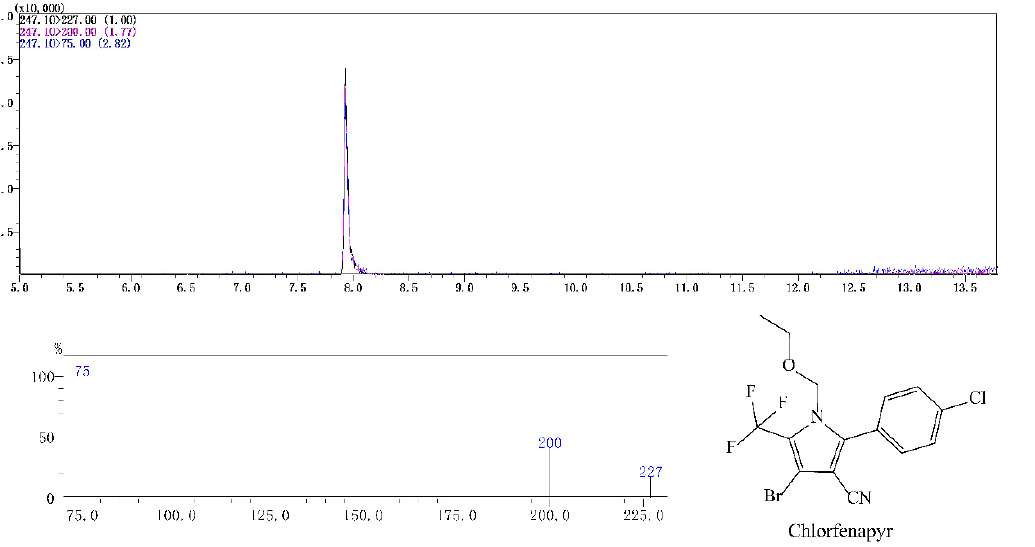
Figure 2. Typical spectra of chlorfenapyr in radish matrix extract detected by GC-MS/MS. The con- centration of chlorfenapyr was 0.1 mg/L.